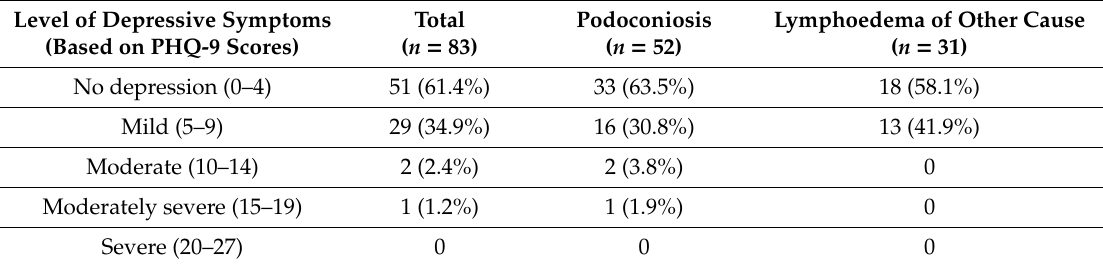
Table 2. Depressive symptoms reported by